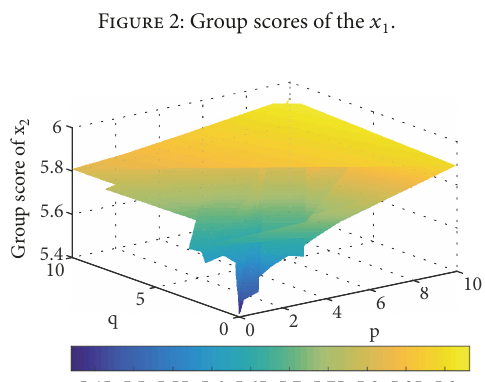
Figure 3: Group scores of the 𝑥 2